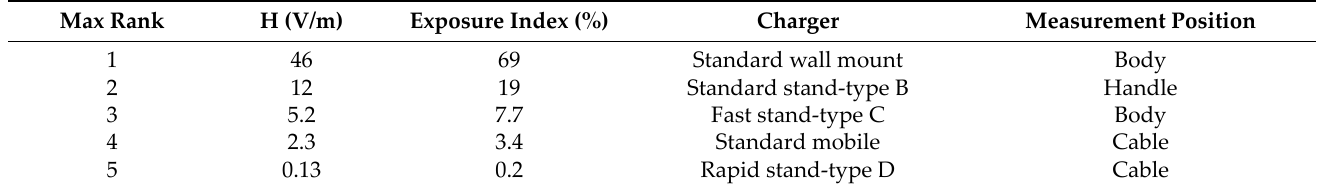
Table 6. Summary of the maximum ranking of magnetic field measurement results.